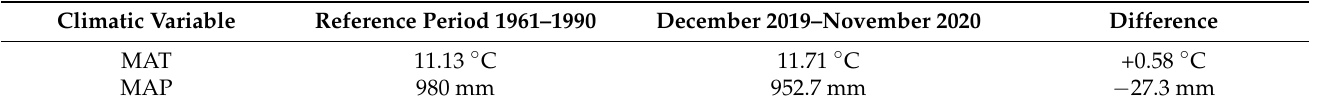
Table 5. Comparison of the most important climatic variables related to the survival response function, corresponding to the reference period 1961–1990 and the data obtained by averaging the test sites. Climatic